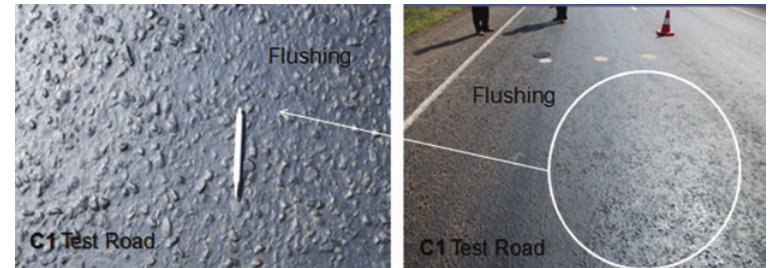
Figure 3: Flushing deterioration at C